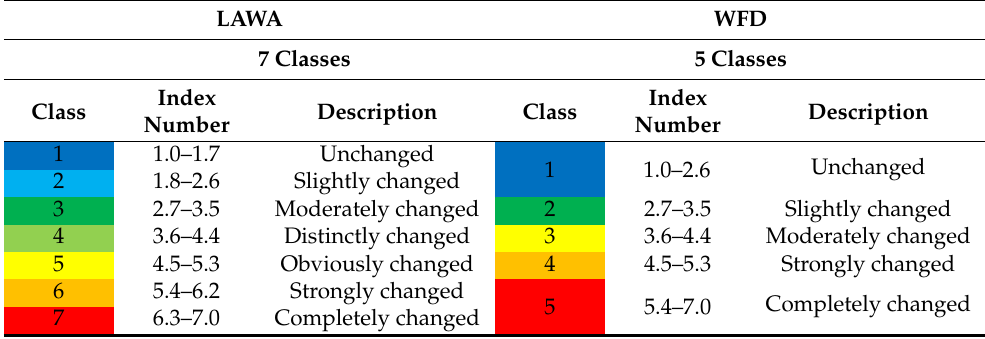
Table 1. Conversion of the hydromorphological structure from the German field survey method